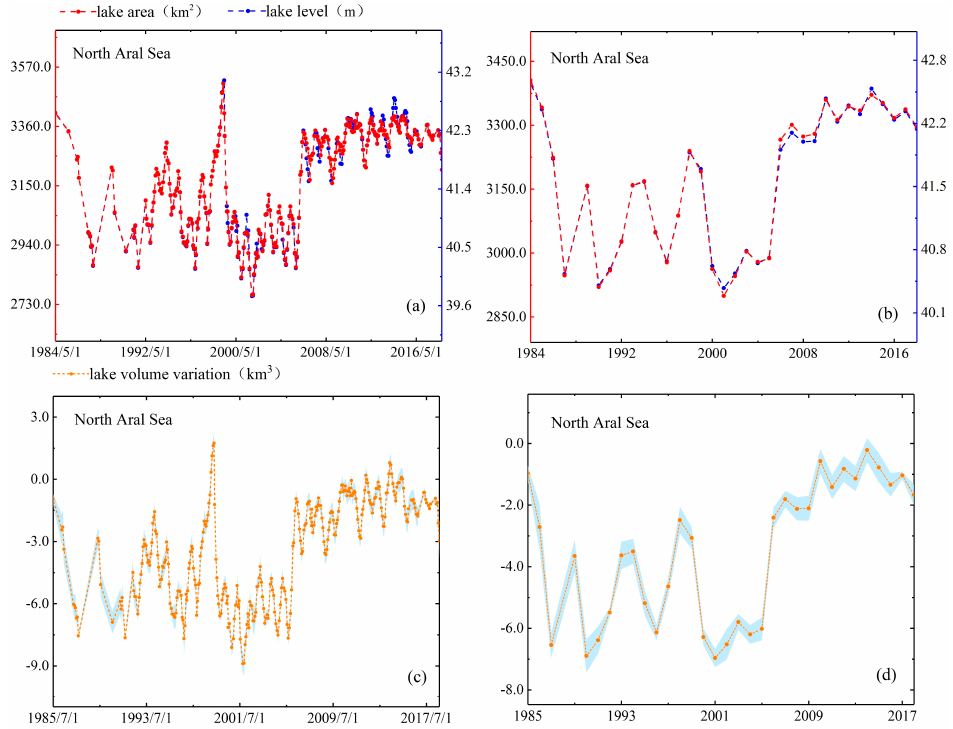
Figure 6. Lake area, level and volume variations in monthly ( a , c ) and annual ( b , d ) timescales for North Aral Sea.